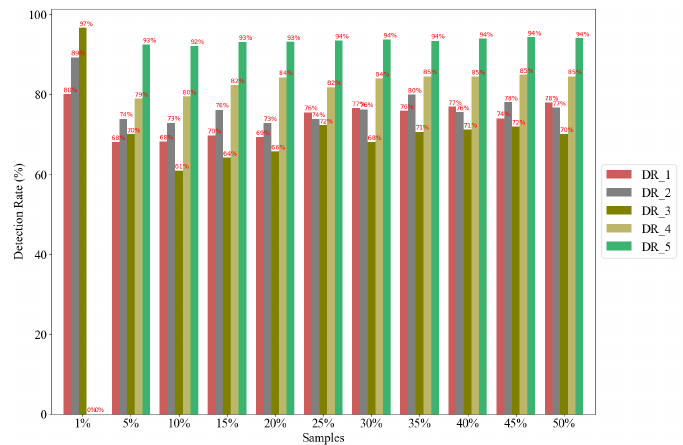
Figure 17. Detection rate for all gridlock labels after prediction with LSTM.